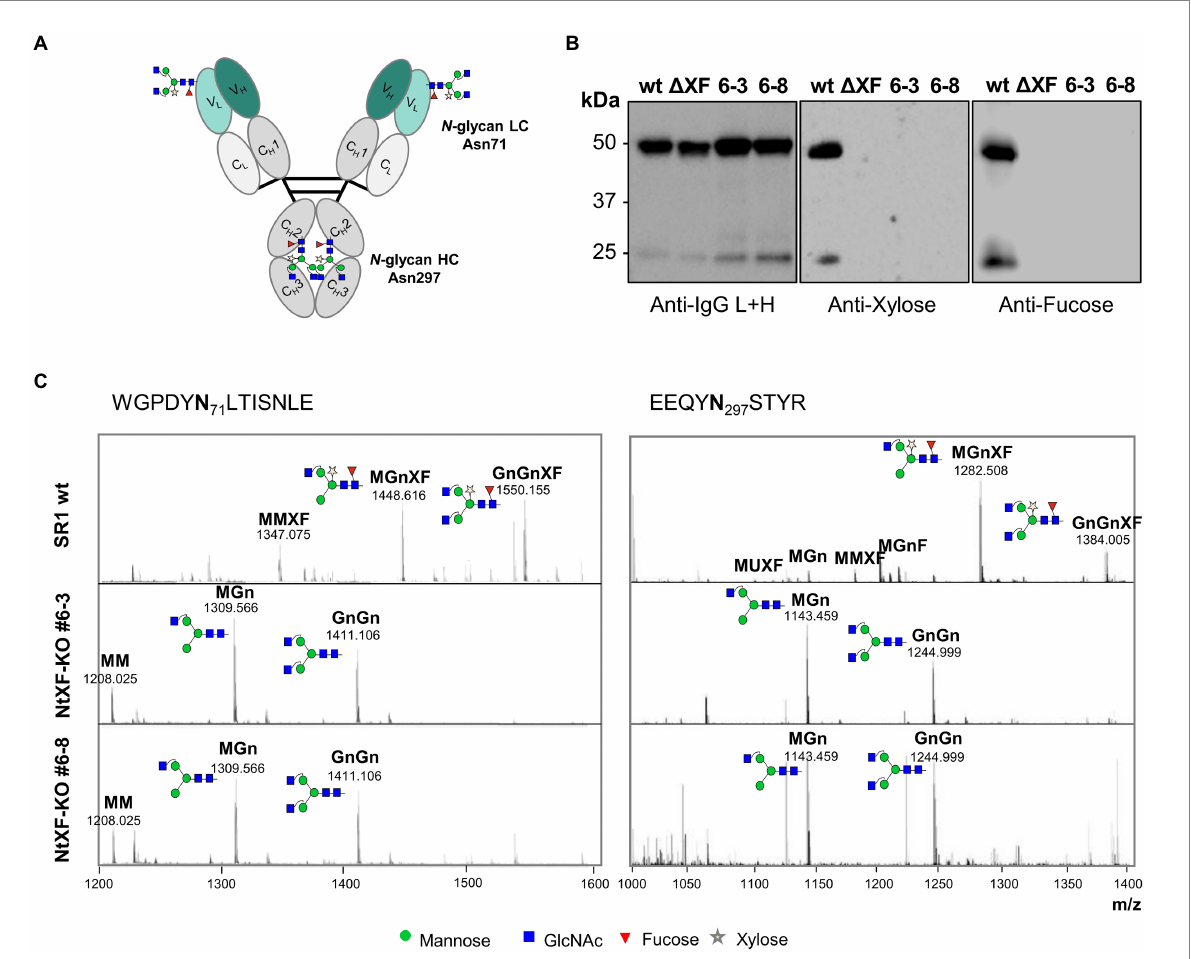
FIGURE 2 Analysis of N -glycosylation of purified VRC01 from transgenic NtFX-KO lines. (A) N- linked glycosylation sites on VRC01. There are four sites in total – two at position Asn71 in the FR3 of the light chain V L region, and two at position Asn297 of the heavy chain CH2 region. (B) Western blot analysis of 200 ng of VRC01 purified from Nicotiana tabacum wild-type (wt), transgenic lines NtFX-KO #6–3 and #6–8, as well as N. benthamiana Δ XT/FT ( Δ XF; kindly provided by BOKU Vienna), under reducing conditions. Membranes were probed with HRP-labeled anti-IgG L + H chain antisera as well as rabbit anti-xylose and anti-fucose antisera followed by HRP-labeled goat anti-rabbit IgG antisera. (C) Site-specific N -glycosylation of purified mAbs analyzed by LC-ESI-MS of the light-chain (WGPDYNLTISNLE) and heavy-chain (EEQYNSTYR) glycopeptides [both (M + 2H) 2+ ]. N-glycans were abbreviated according to the ProGlycAn system (www.proglycan.com). Please note that just one possible isomer was shown. The symbols for the monosaccharides were drawn according to the nomenclature from the Consortium for Functional